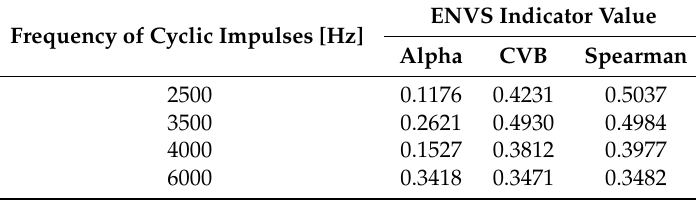
Table 1. The numerical value of goodness of fault detection—Envelope Spectrum-based (ENVS) indicator values for different selectors and changing center frequency of the local fault.